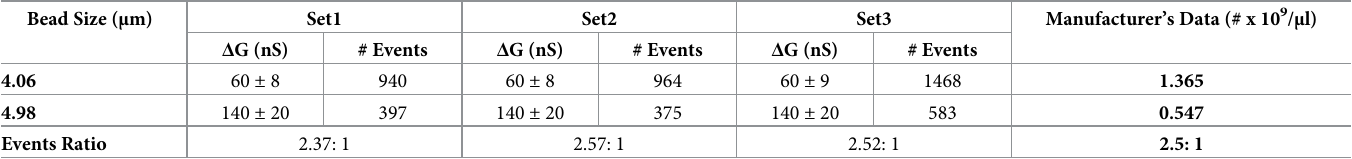
the table. The 4.06 and 4.98 μ m beads mixed in a known ratio of 2.5:1, and the experimental values of the detected ratio for 3 sets are mentioned in the last